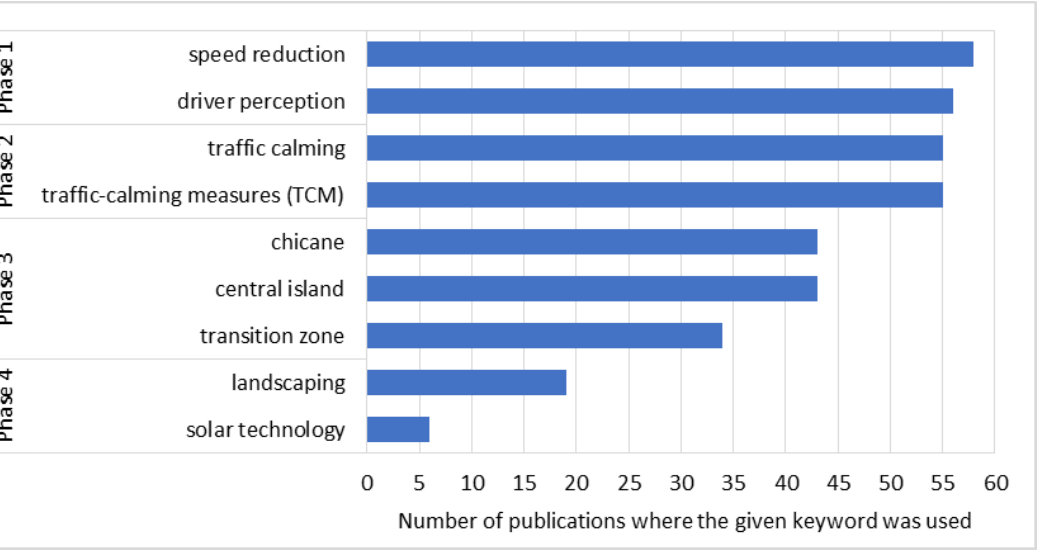
Figure 2. Number of found studies for particular keywords.